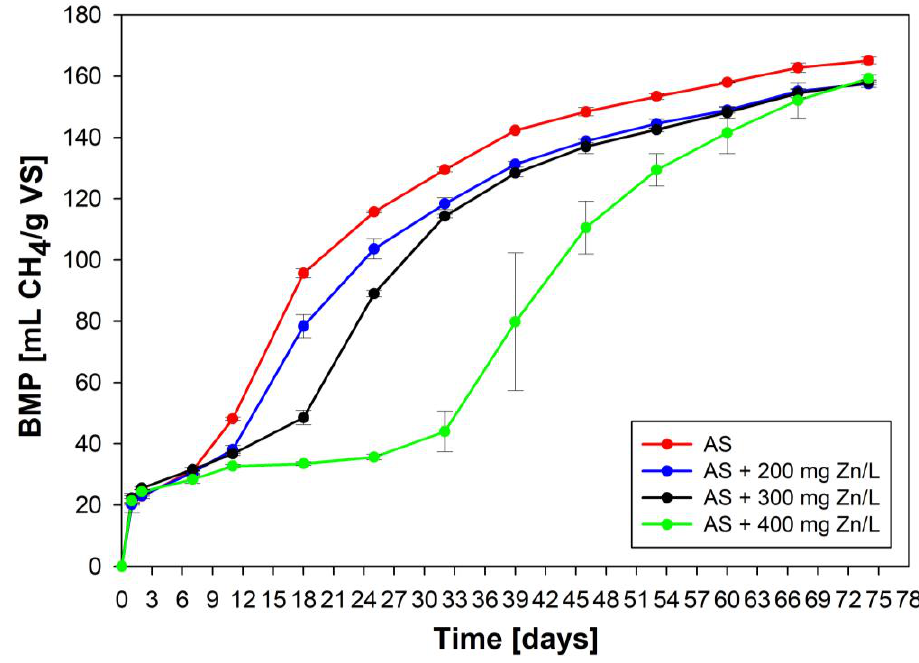
Figure 2. Cumulative biomethane profiles of the activated sludge (AS) at increasing zinc concentra- tions over 74 days of anaerobic digestion. Values and error bars represent the averages and standard deviations of triplicates for each experimental condition, respectively. AS = activated sludge.